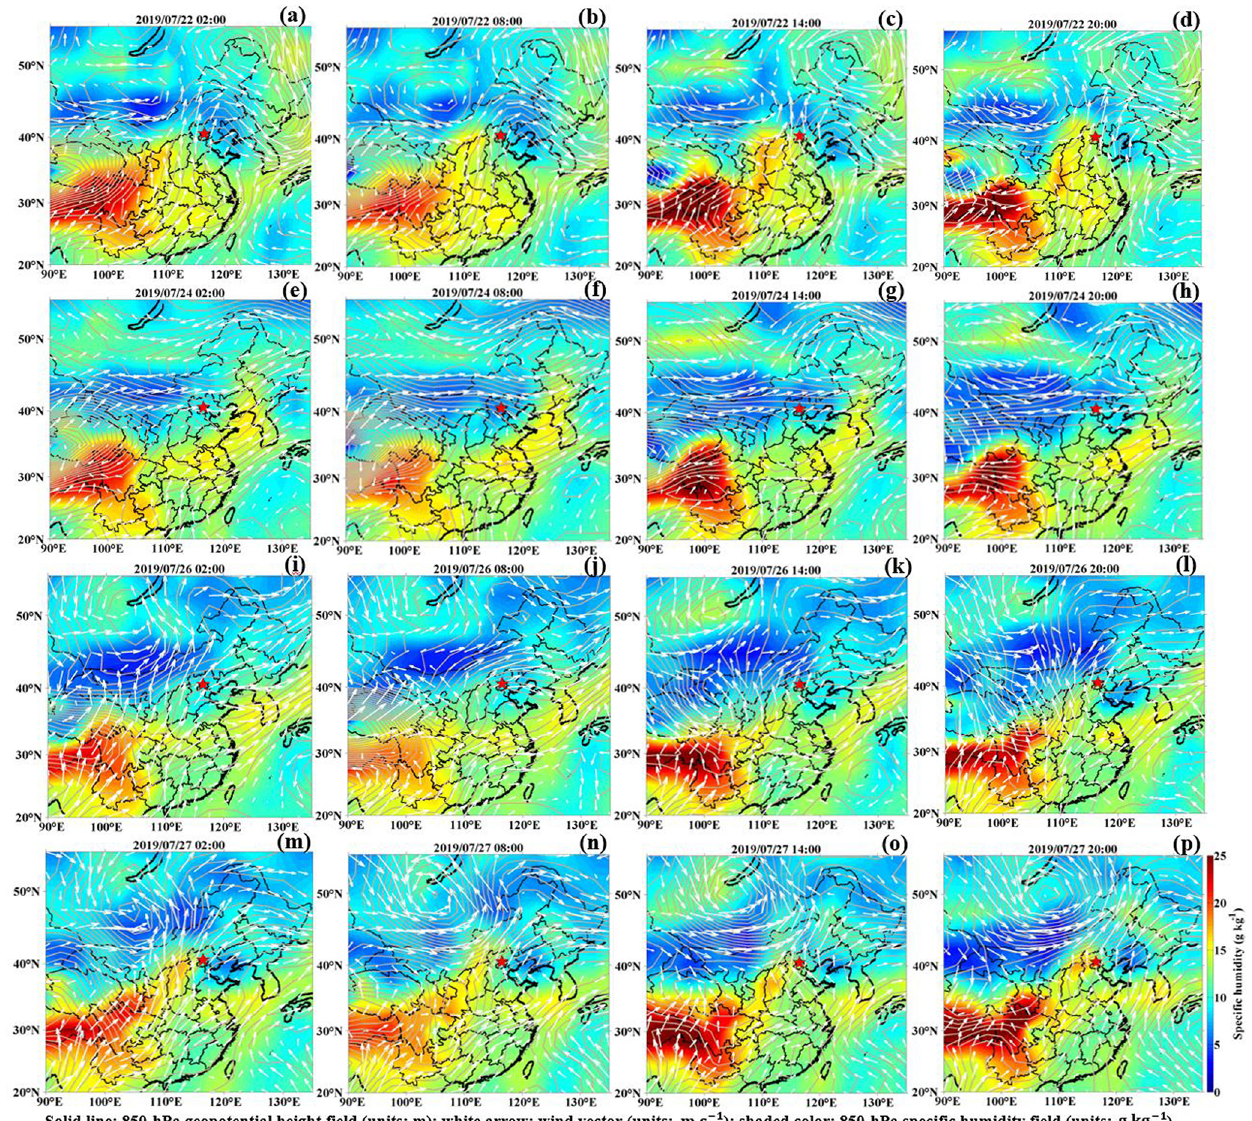
Figure 7. Composites of the 850hPa horizontal wind vector field (units: ms − 1 ; white arrows), 850hPa geopotential height field (units: m; solid lines) and 850hPa specific humidity field (units: gkg − 1 ; shaded colors) at 02:00, 08:00, 14:00 and 20:00LT on 22, 24 and 26–27 July, labeled as (a–p) . The star shows the location of the BJ